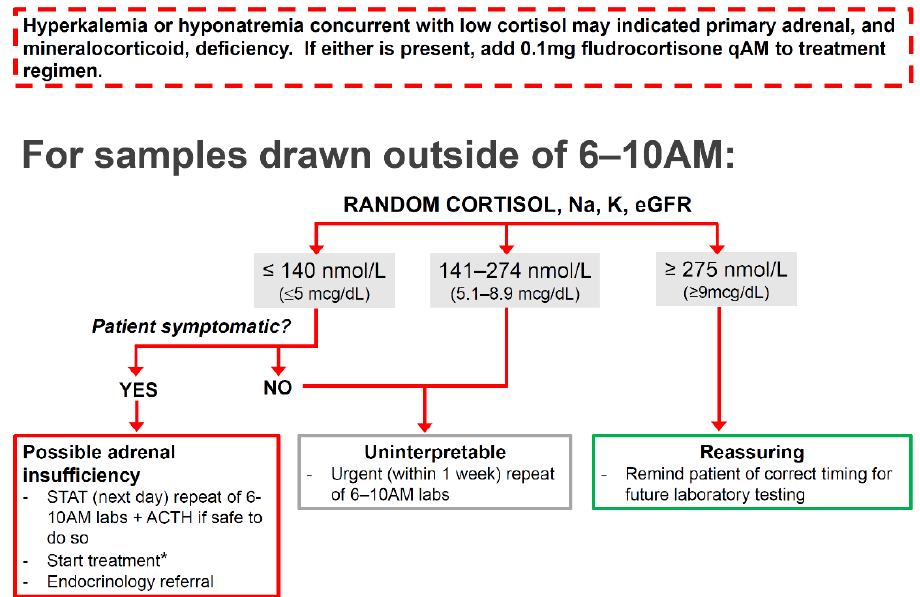
Figure 2. Algorithm for the frequency and interpretation of outpatient screening of asymptomatic patients for immune-checkpoint-inhibitor therapy-associated HPA-axis pathology.